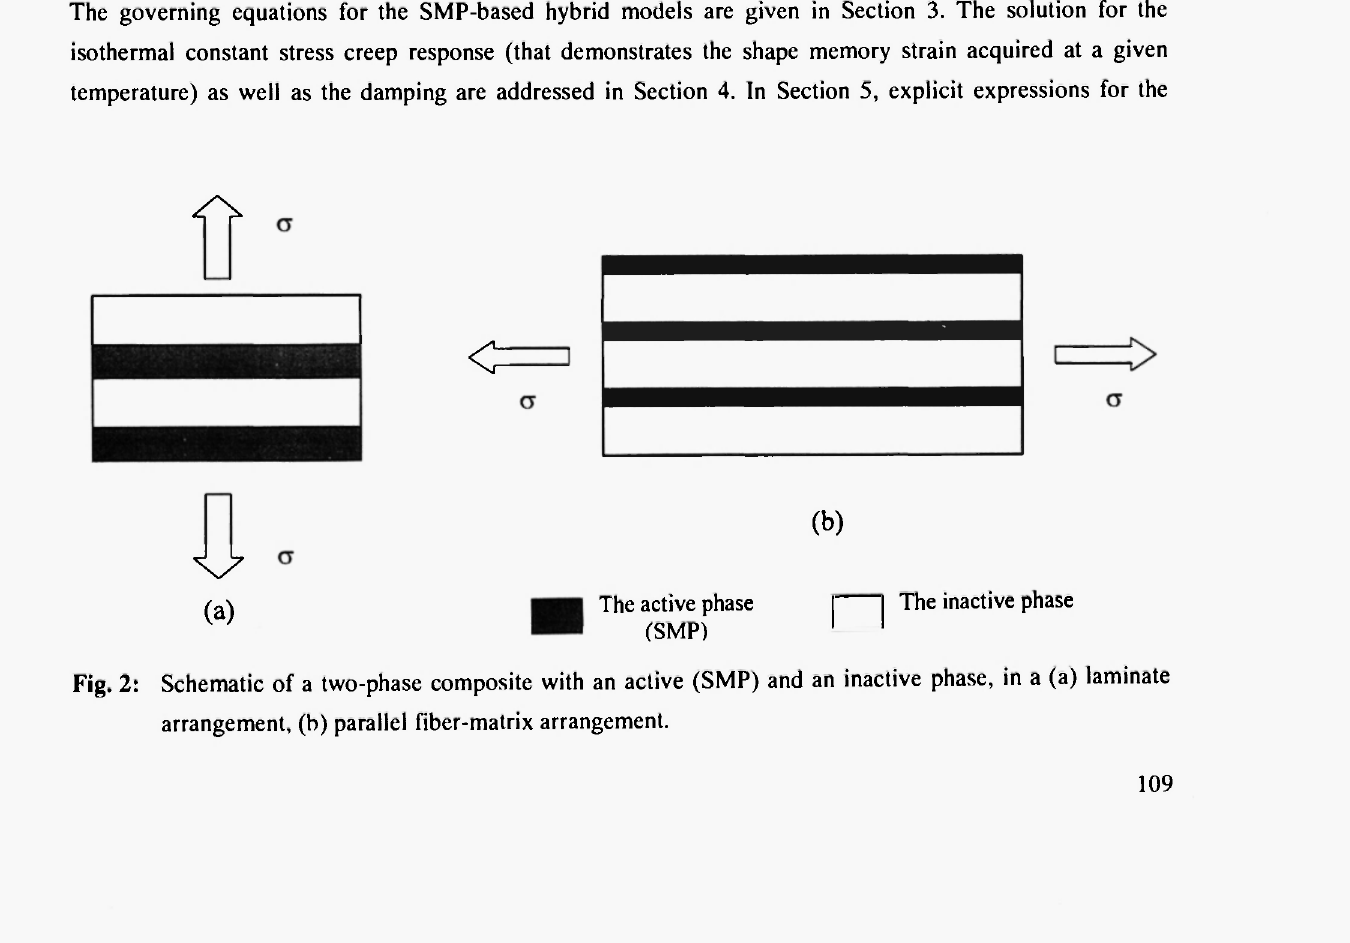
Schematic of a two-phase composite with an active (SMP) and an inactive phase, in a (a) laminate arrangement, (b) parallel fiber-matrix